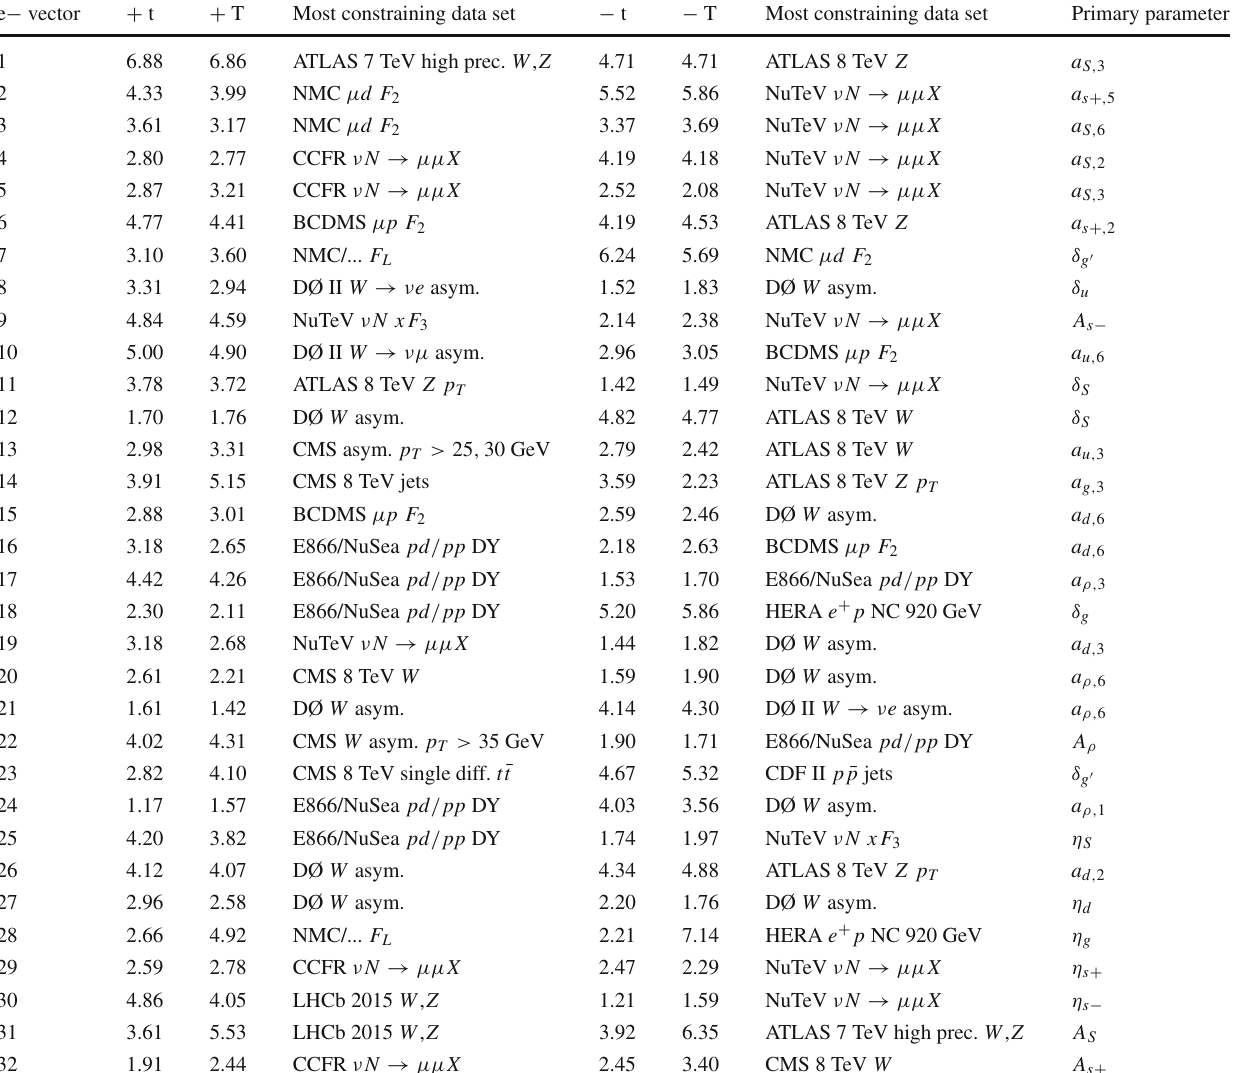
Table 9 The NLO eigenvectors (in both directions) for the default ) = 0 . 118 global NLO fit, including the tolerances for MSHT20 α S ( M 2 Z each eigenvector, the data set which most constrains that eigenvector